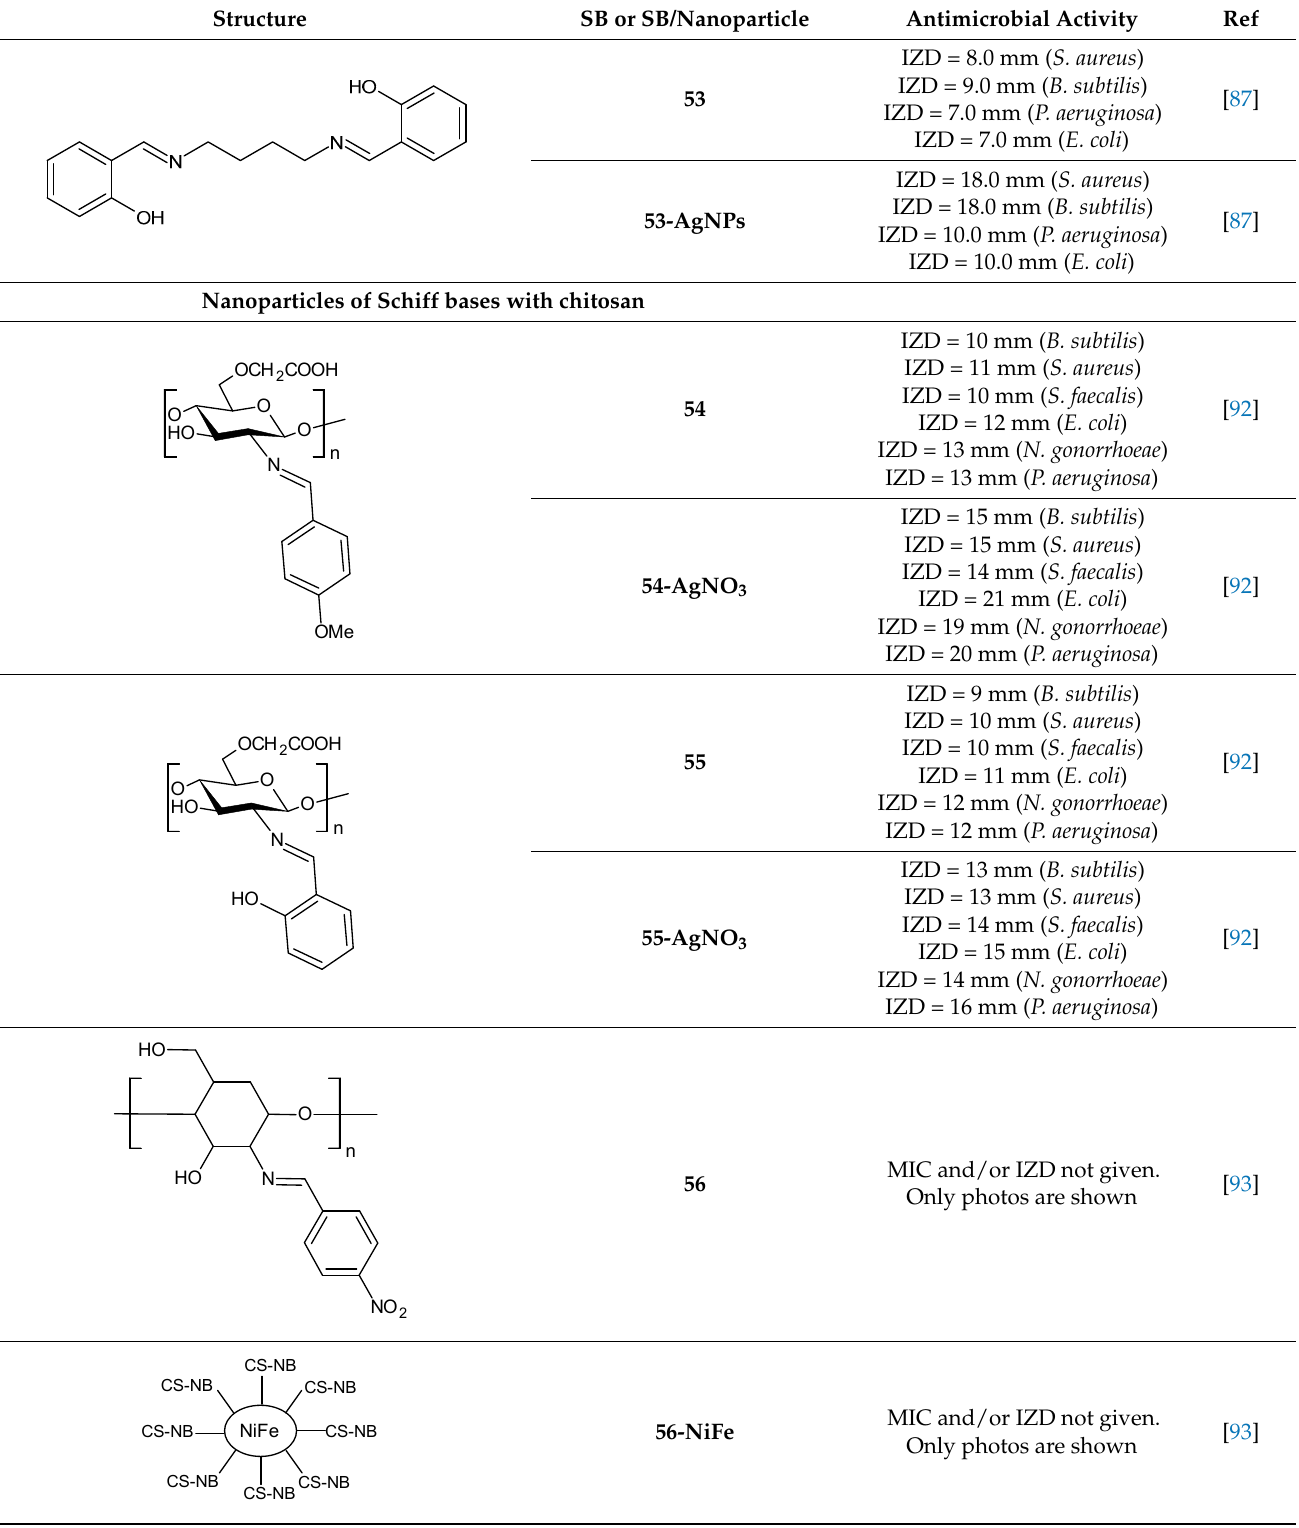
Table 4. Structure and antibacterial activity of nanoparticles of SBs and CBSs.